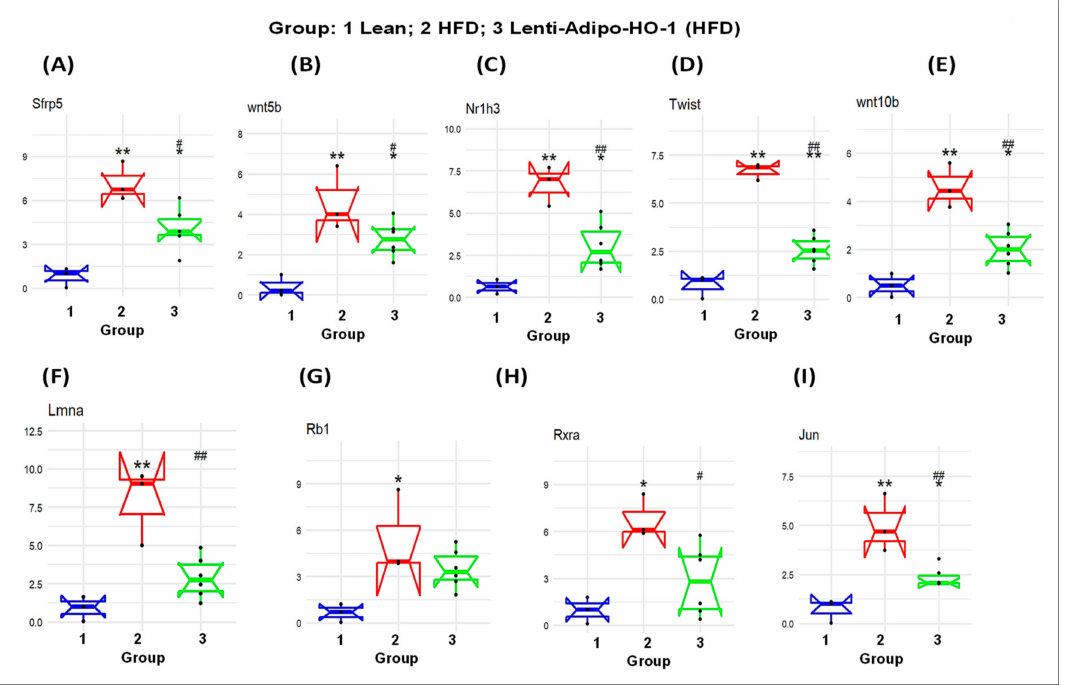
Figure 10. The mRNA expression of lean (Group 1) mice, HFD (Group 2) mice, and Lnv-adipo-HO-1 (HFD) mice (Group 3). ( A ) sfrp5, ( B ) wnt5b, ( C ) Nr1h3, ( D ) Twist, ( E ) Wnt10b. ( F ) Lmna ( G ) Rb1 ( H ) Rxra ( I ) Jun in adipose tissue. ( n = 5, * p < 0.05, ** p < 0.005 vs. lean; # p < 0.05, ## p < 0.005 vs. HFD